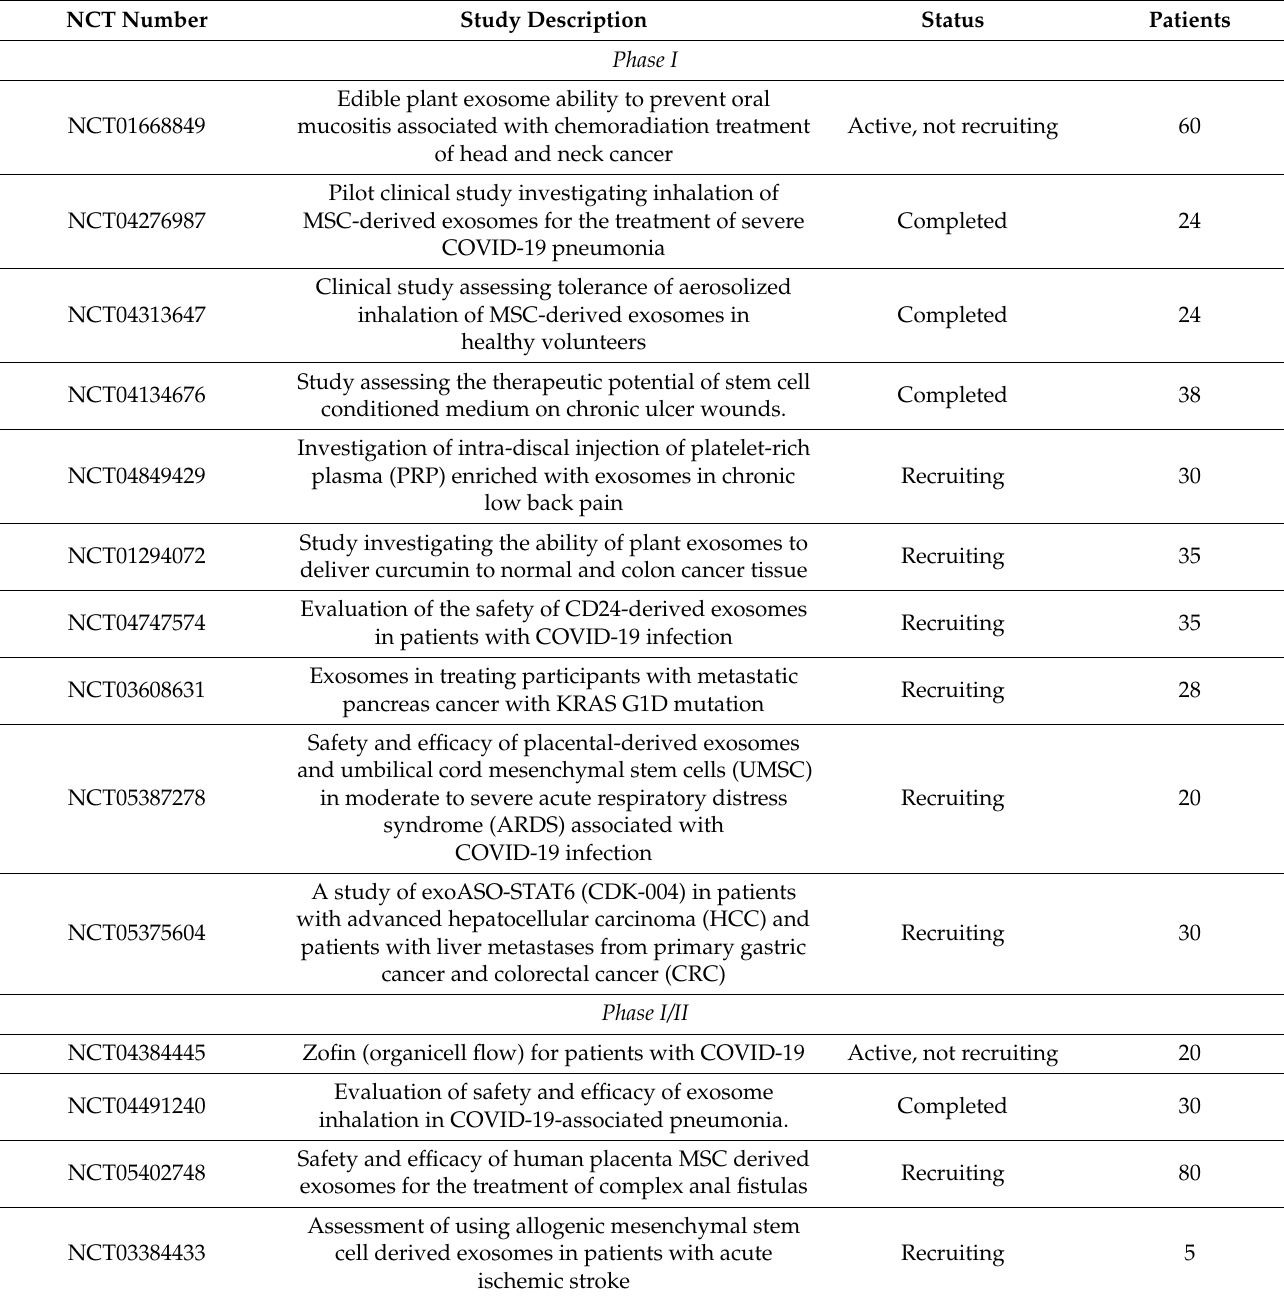
Table 2. Clinical trials investigating EV-based